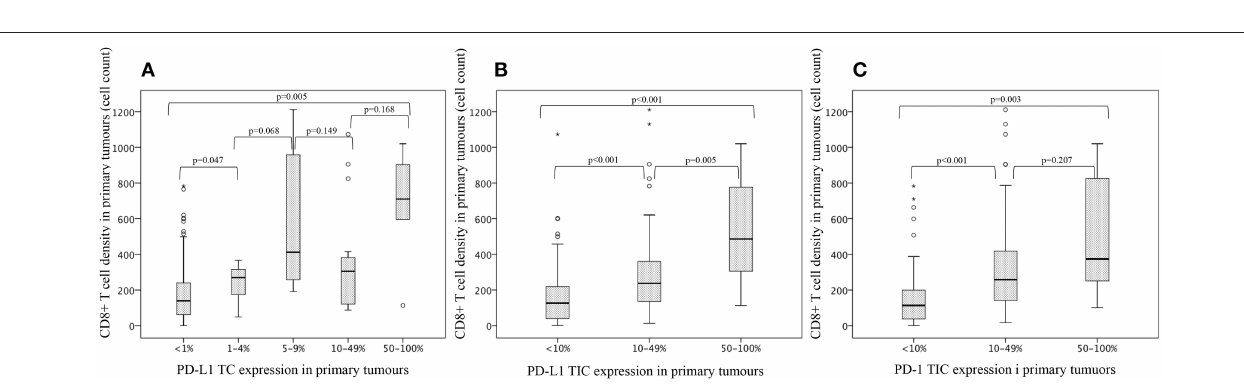
FIGURE 7 | Box plots visualising the associations of CD8 + T cells with (A) PD-L1 expression on tumour cells and (B) PD-L1 expression on tumour-infiltrating immune cells and (C) PD-1 expression on tumour-infiltrating immune cells, in primary tumours in the entire